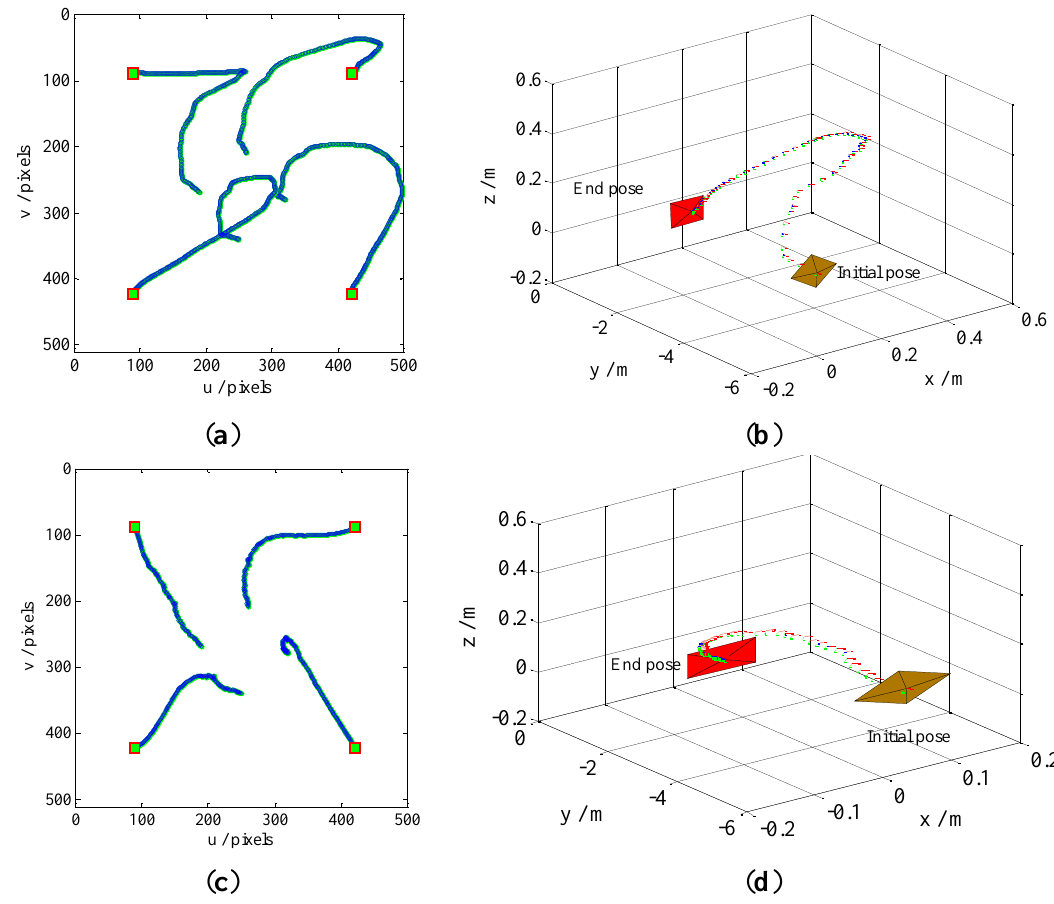
Figure 10. Comparison of our method with KBF for Case 3. The additive noises are set at zero mean, and the variances are set at 9 × 10 −3 . ( a ) Feature trajectories by KBF; ( b ) Camera trajectory by KBF, camera with serious retreat; ( c ) Feature trajectories by our method; ( d ) Camera trajectories by our method, camera without